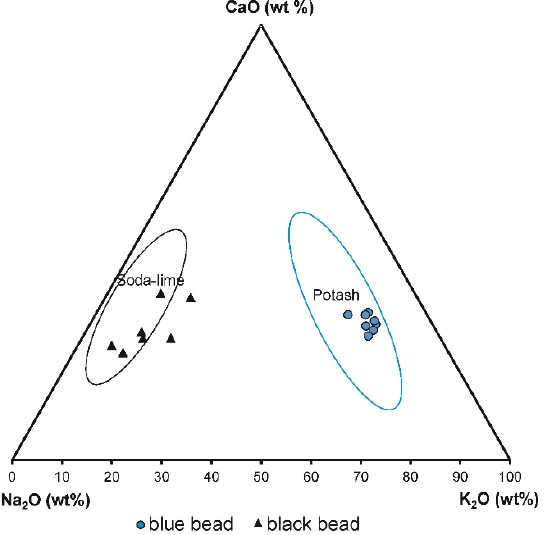
Figure 13. Variety of the glass flux compositions depicted in the Na 2 O–K 2 O–CaO ratio [20]. A diagram plotting the aluminium oxide content, magnesium and potassium oxides content (typical of plant ash glasses) and calcium oxide content against each other shows that both blue and black beads represent low alumina glass plant ash. (Figure 14). This